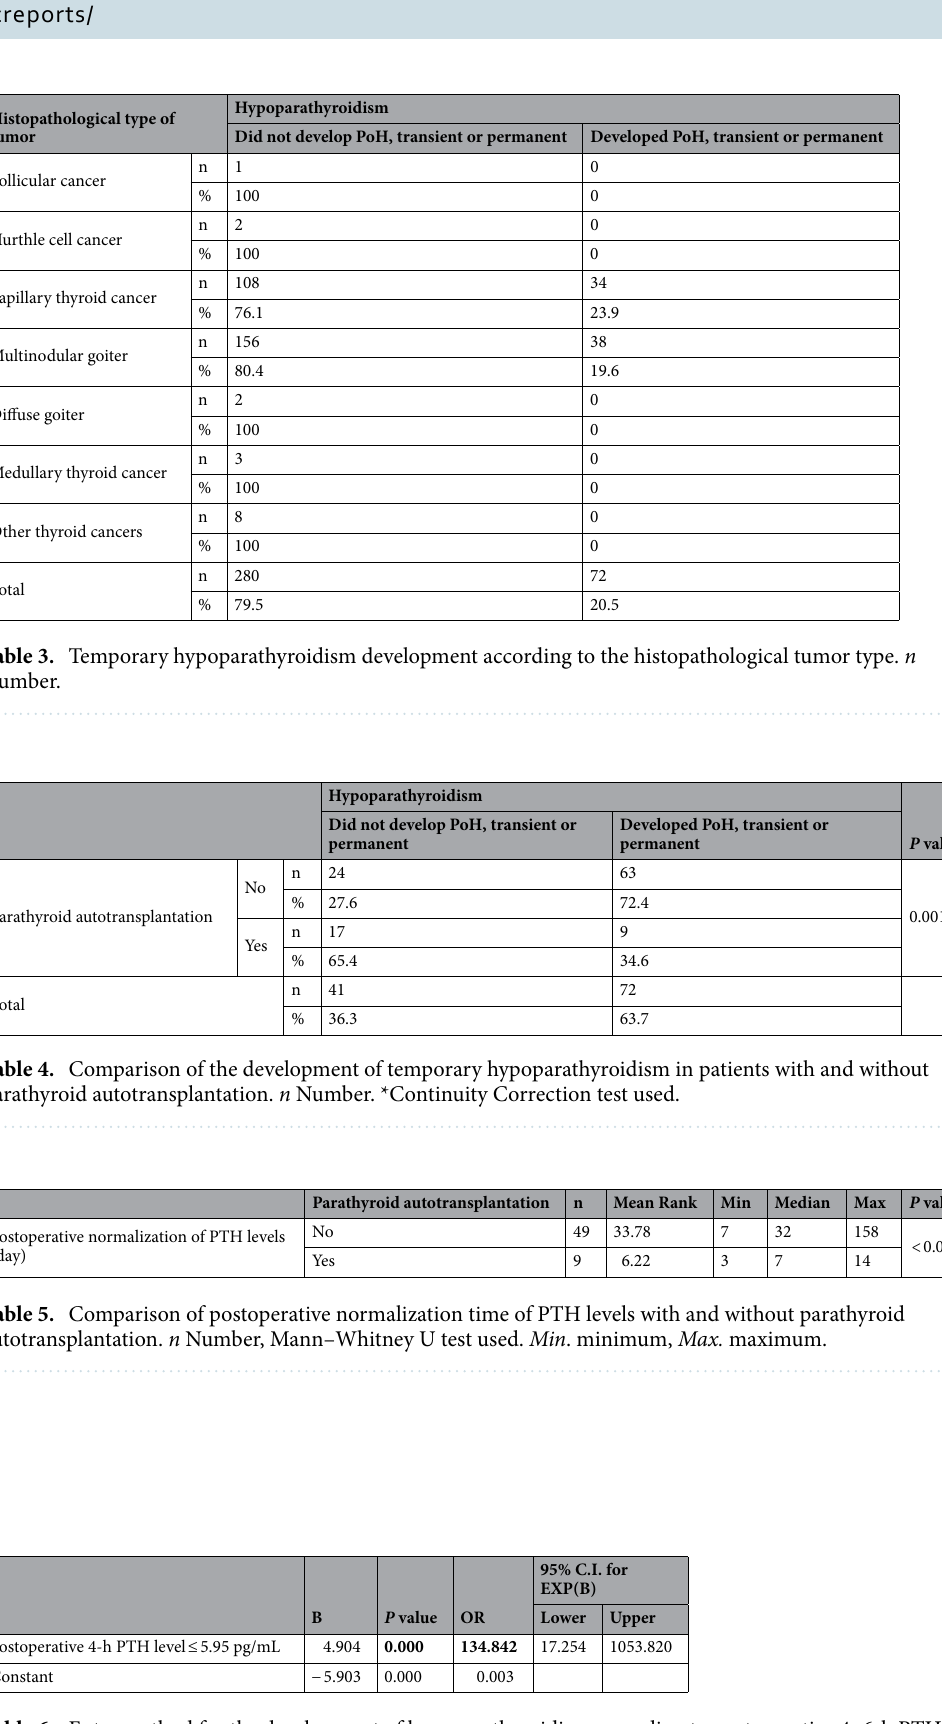
Table 6. Enter method for the development of hypoparathyroidism according to postoperative 4–6-h PTH levels. Pseudo (Nagelkerke) R 2 = 0.463, Hosmer–Lemeshow χ 2 = 93.718 p < 0.001. Dependent variable: 0 =